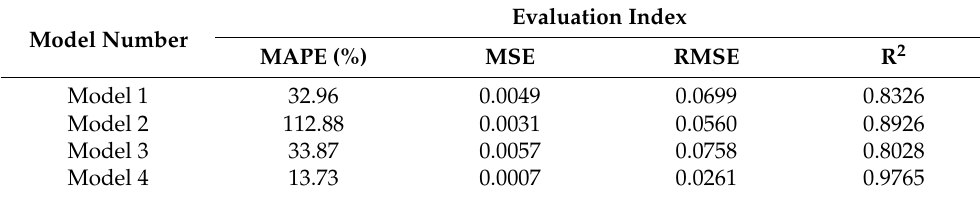
Table 5. Evaluation index values of different models of random displacement.